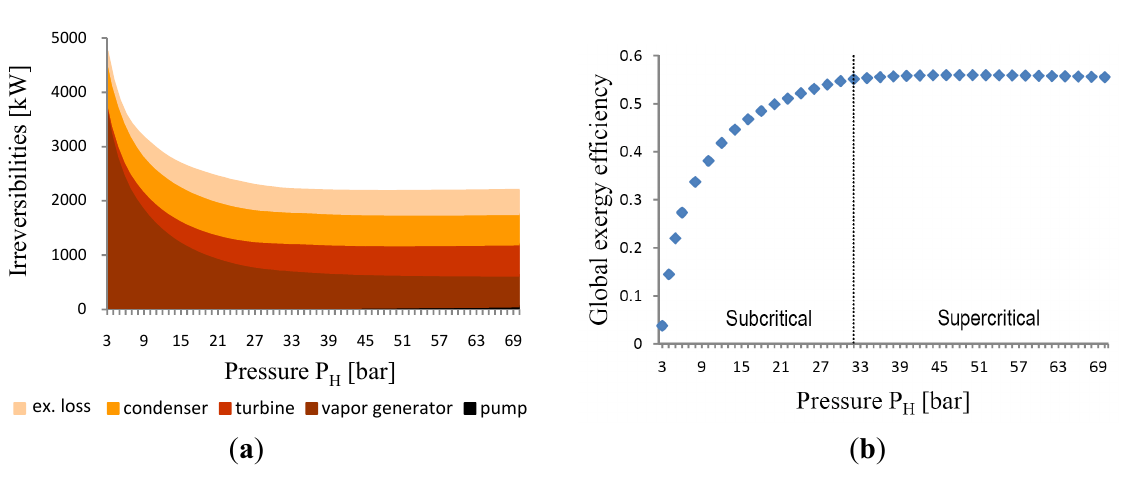
Figure 5. R-236fa global performance from almost dry resource. ( a ) Irreversibilities diagram; ( b ) Global exergy efficiency behavior.